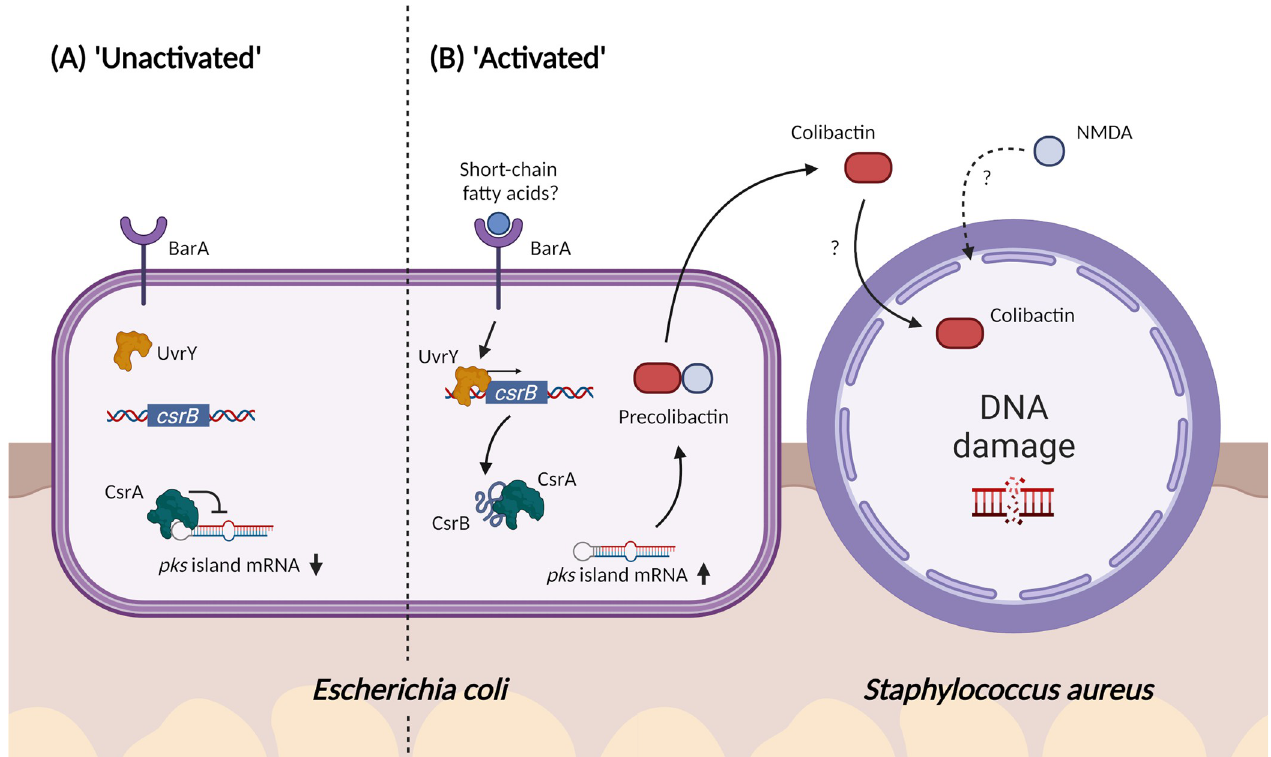
Fig 7. Proposed model of E . coli and S . aureus polymicrobial interactions. (A) In the absence of a signal, the BarA-UvrY two component system (TCS) is inactive. CsrA regulates the pks island negatively by binding the mRNA of ClbR, leading to the downregulation of pks island genes. (B) When E . coli and S . aureus are in proximity, the BarA-UvrY TCS is activated by the presence of specific signals, such as short-chained fatty acids. Activation of the TCS leads to upregulated expression of sRNA CsrB, which is a negative regulator of CsrA. CsrB binds to CsrA and relieves the suppression on the pks island, resulting in the upregulation of pks island genes and increased synthesis of pre-colibactin. Maturation of pre-colibactin leads to the release of both NMDA and colibactin into the environment. Entry of colibactin into S . aureus , which possibly occurs through NMDA-mediated membrane disruptions, ultimately leads to DNA damage and growth inhibition of S . aureus . The exact mechanism of colibactin entry into S . aureus remains to be determined. Created with